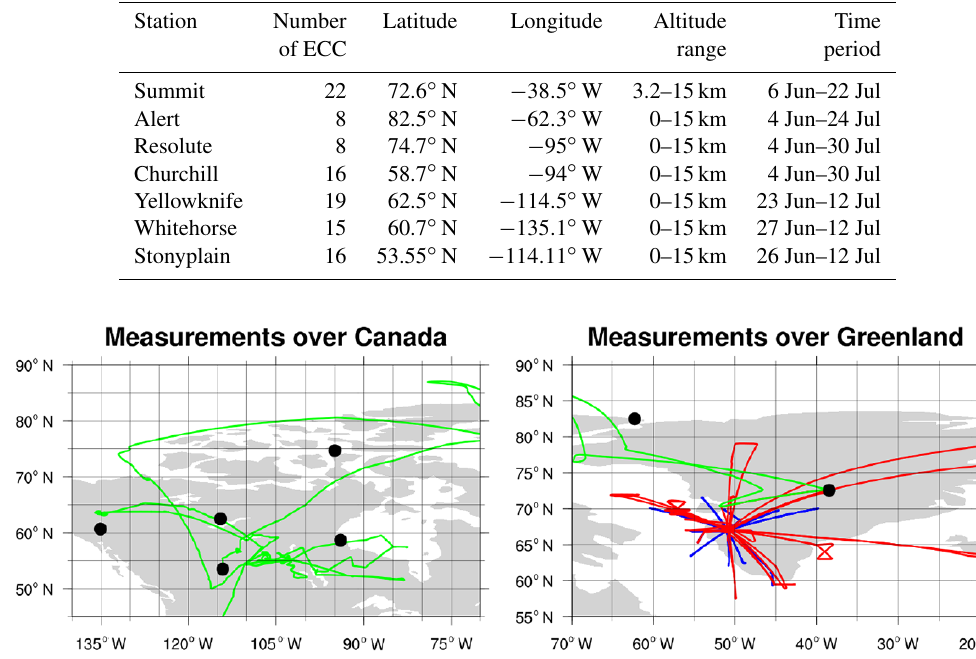
Figure 1. Horizontal distribution of the DC-8 (green), ATR-42 (blue), DLR Falcon-20 (red) flights and ECC sounding locations (black dot) over the selected Canada (left panel) and Greenland regions (right